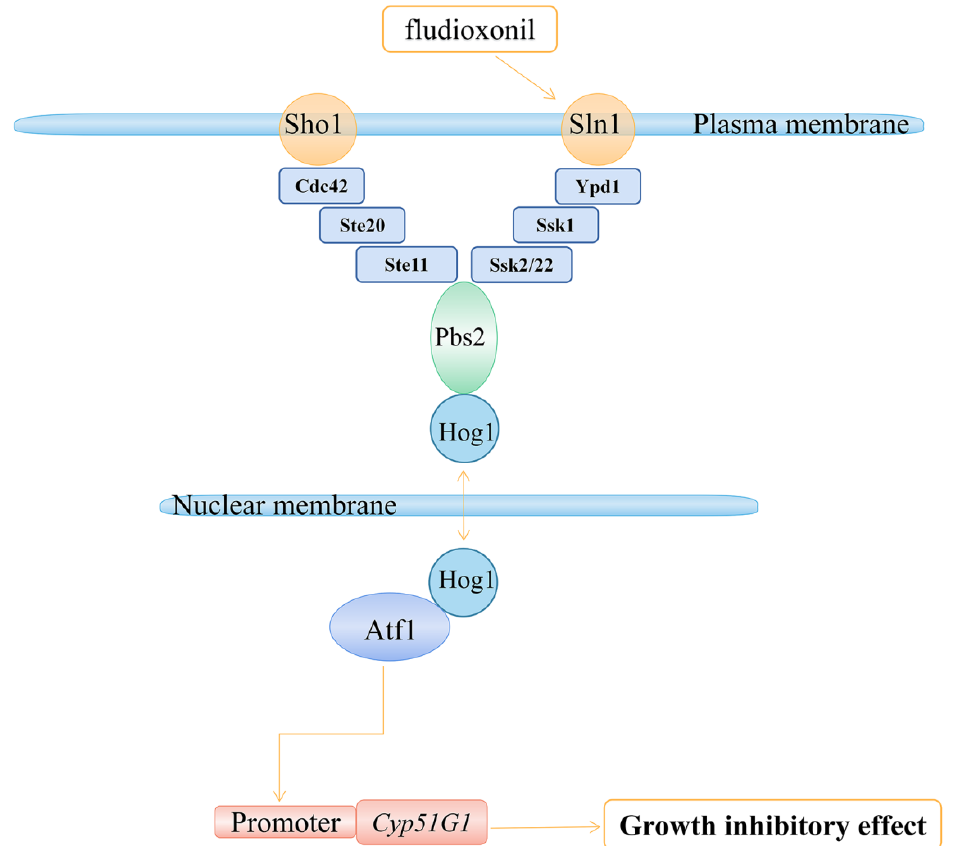
Figure 8. Proposed model from our study showing that CsAtf1 downregulates CsCyp51G1 expression levels, leading to fludioxonil sensitivity.